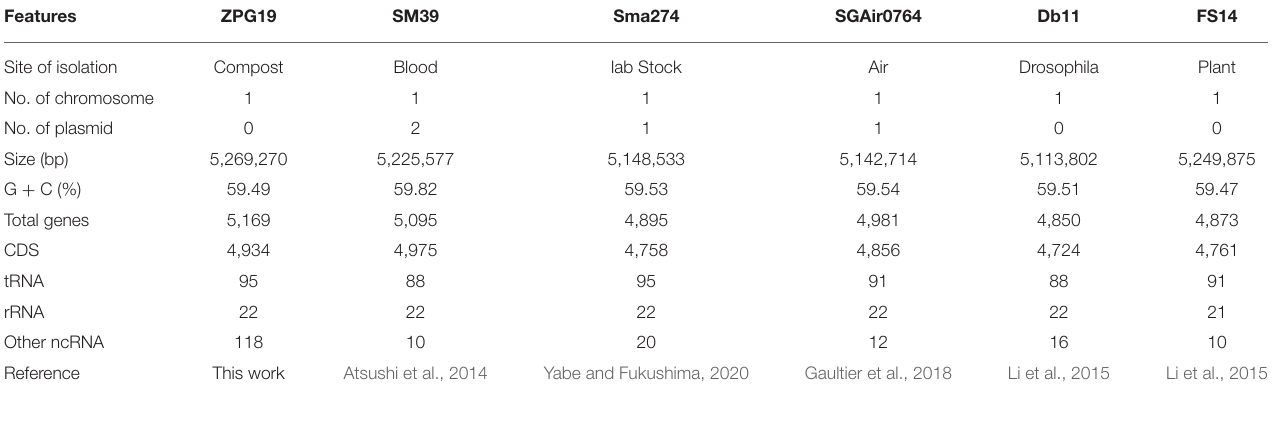
TABLE 1 | Detailed information of Chromosomal genomes from S. marcescens Strain ZPG19 and five reported S. marcescens strains.